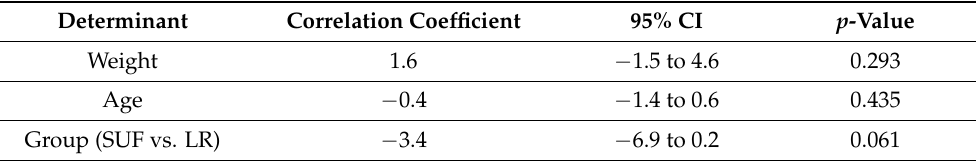
Table 5. Analysis of the determinants of the difference in UNESP-Botucatu scores between hours 8 and 0 in a multivariate linear regression